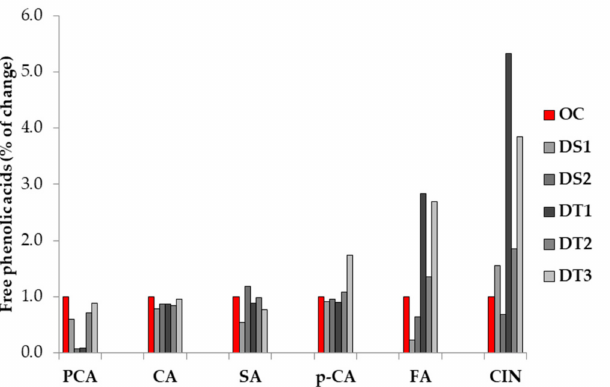
Figure 2. The percentage of changes for phenolic acids under water deficit stress (non-irrigation treatment—I 0 ) compared to the optimal conditions (irrigation treatment—I 75 ) evidenced in drought tolerant (DT1, DT2, and DT3) and drought susceptible (DS1 and DS2) inbreds. OC—values measured under optimal conditions given as 1